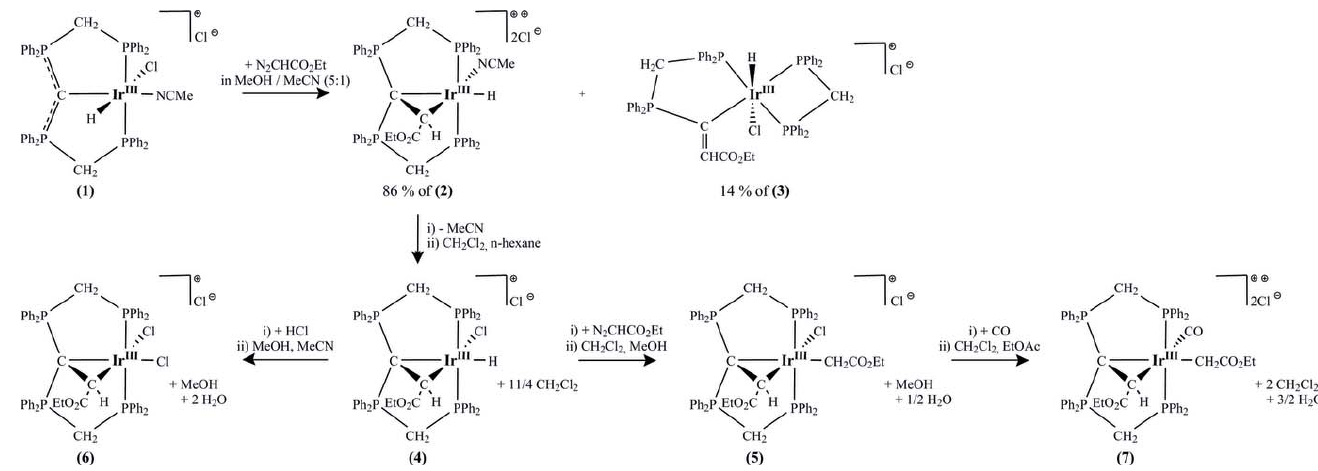
Figure 1 Scheme (Cambridge Soft, 2001) for the synthesis and crystallization of the title compounds 4 – 7